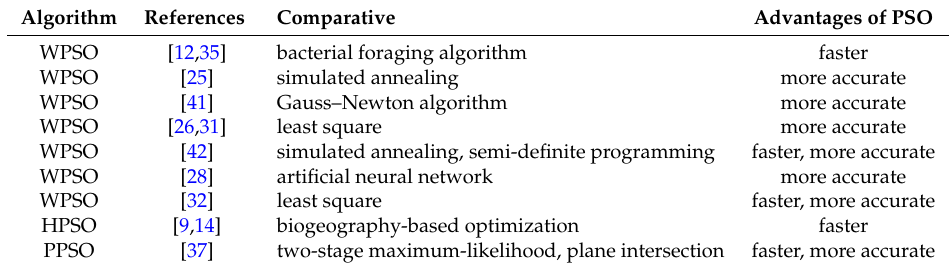
Table 1. Advantages of particle swarm optimization (PSO)-based localization algorithms. HPSO: H-Best PSO; PPSO: PSO with particle permutation; WPSO: